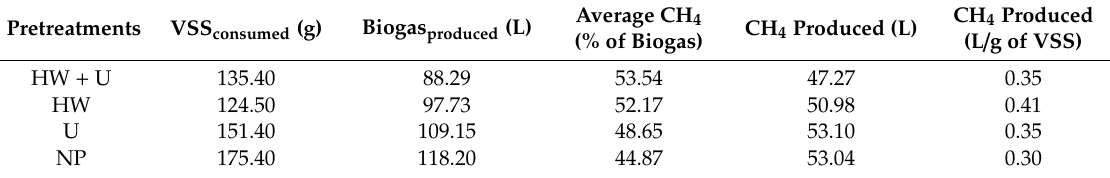
Figure 4. Ultimate analysis of the substrate during the digestion process of microalgae. Table 4. Production of methane by microalgae with different pretreatments.